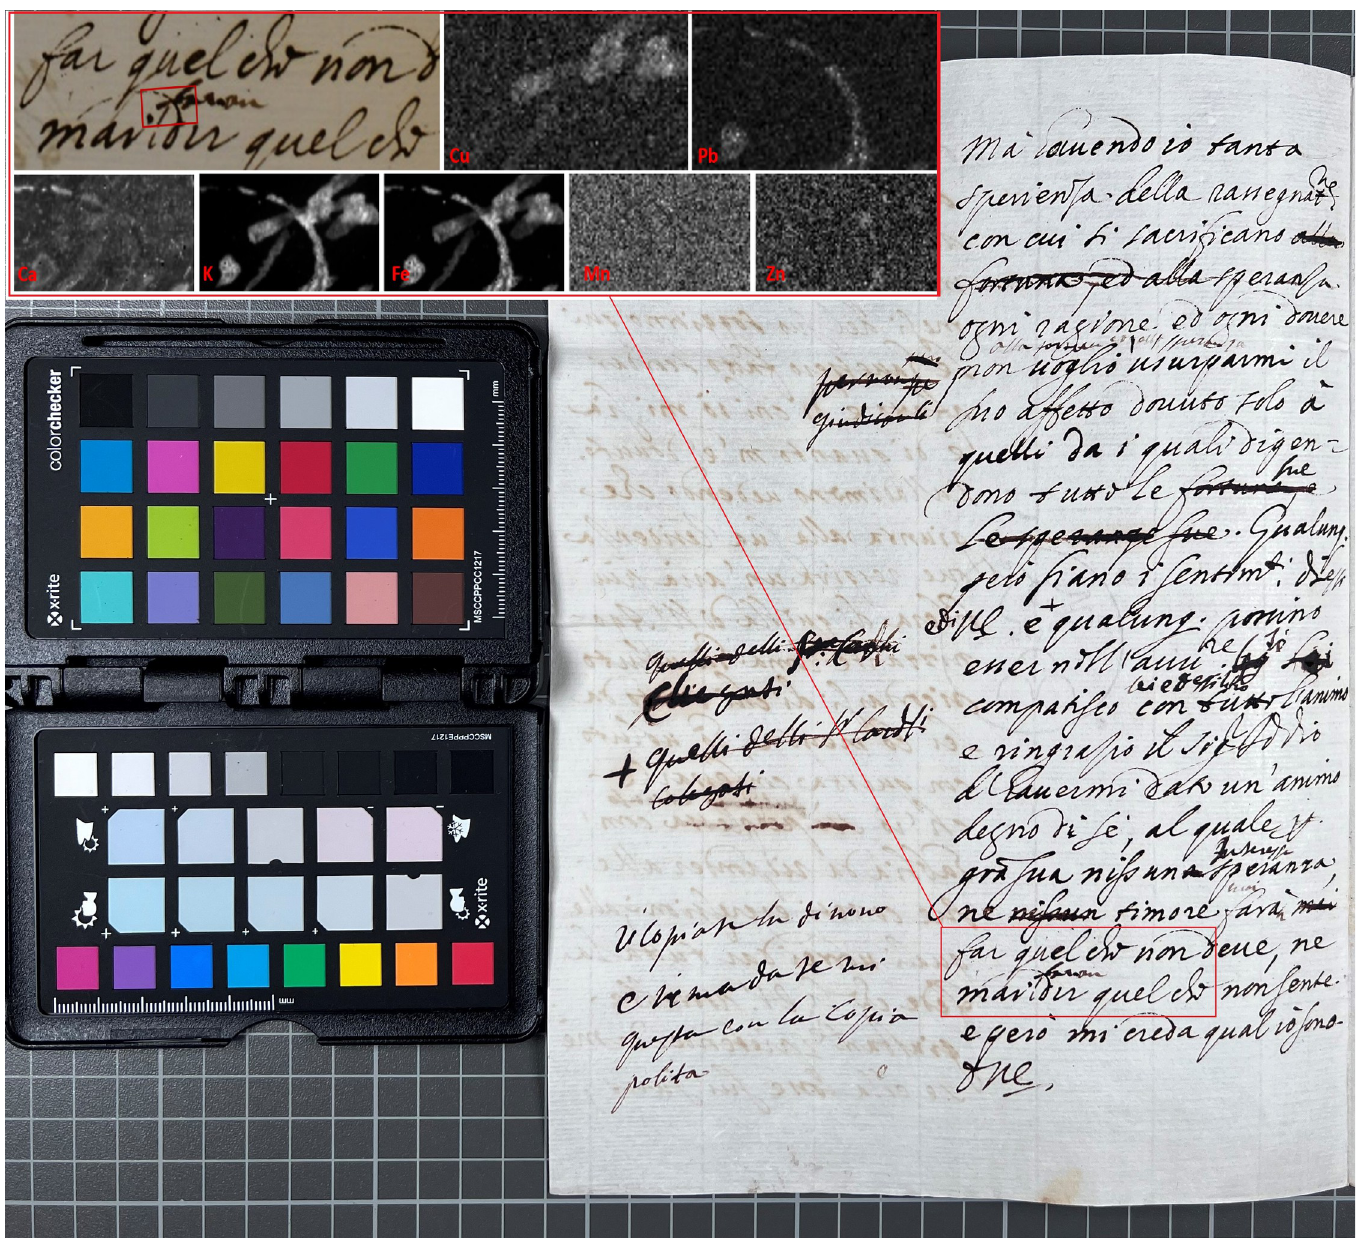
Fig 20. One document, two hands–two inks. XRF map (5600 points) from K408 1556 of area with text written by the Queen’s secretary and notes by herself. Ink used by secretary contains lead but not copper, ink used by Christina contains copper but not lead. Outliers were removed (7 points) to improve contrast in the calcium map.